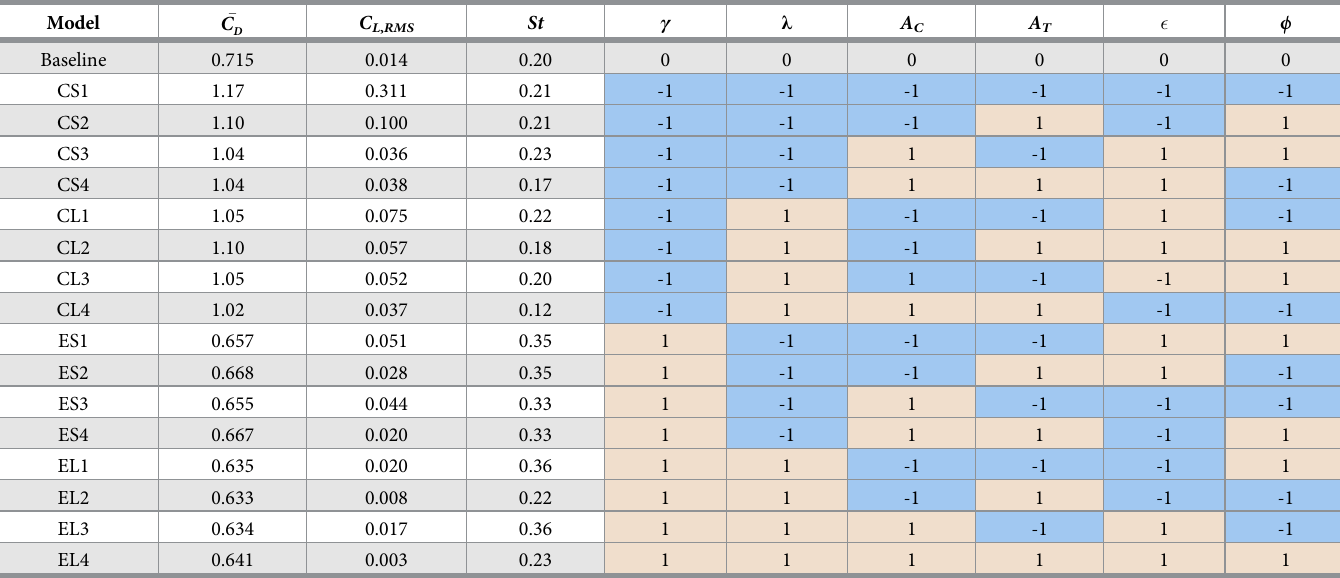
Table 5. Measured response variables by model and geometric